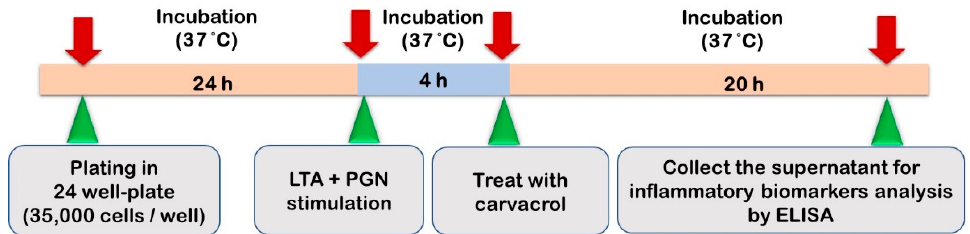
Figure 2. The LTA- and PGN-stimulated tonsil epithelial cell inflammatory model system used in the study.